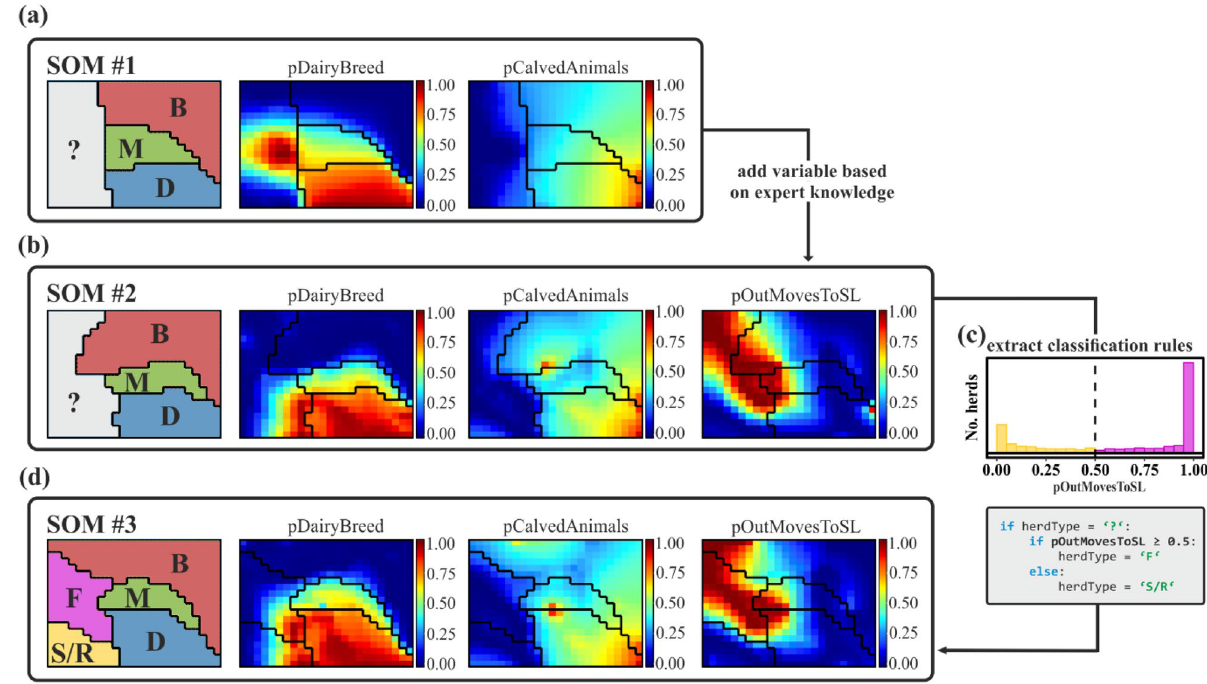
Figure 2. Rule extraction from self-organising-maps (SOMs). Class boundaries are represented as black lines and refer to beef (B), dairy (D), Mixed (M), fattening (F) and store/rearing (S/R) herds. The left most panel highlights the organisation of herd types in the SOM and the other panels show the component planes per input variable. Colour coding shows the values of the respective variable in a given pixel. ( a ) SOM #1 trained with 2 variables and pre-classified data (left panel). ( b ) SOM #2 trained with one additional variable ( pOutMovesToSL ) and its component planes. ( c ) Distribution of the pOutMovesToSL variable among the unclassified herds (grey region in left panel) and identification of a purposefully chosen threshold for class assignment i.e. 0.5. ( d ) SOM #3 trained with the 3 variables and the reclassified dataset (B, M, D plus newly F, S/R) and its component